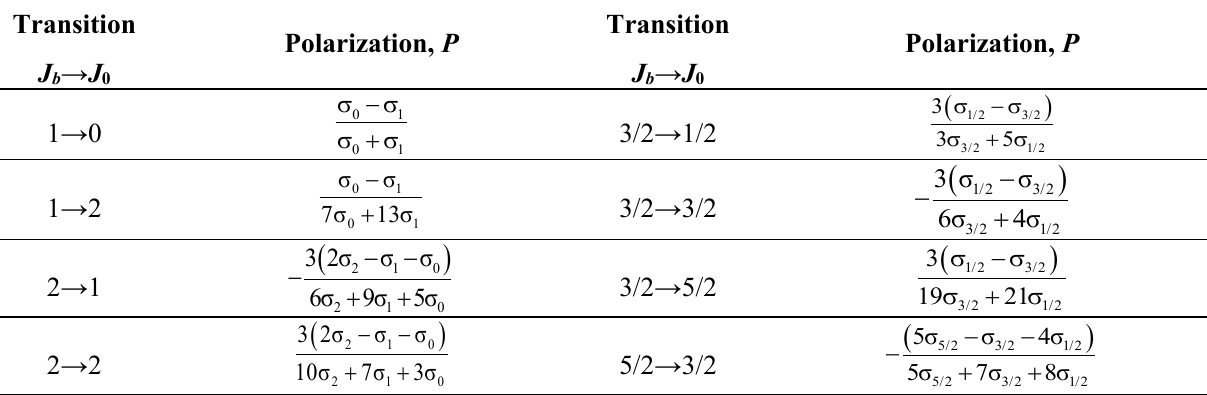
Table 1. Degree of linear polarization of the emitted photon for transition J b → J 0 in terms of magnetic sublevel cross-sections ( σ b M